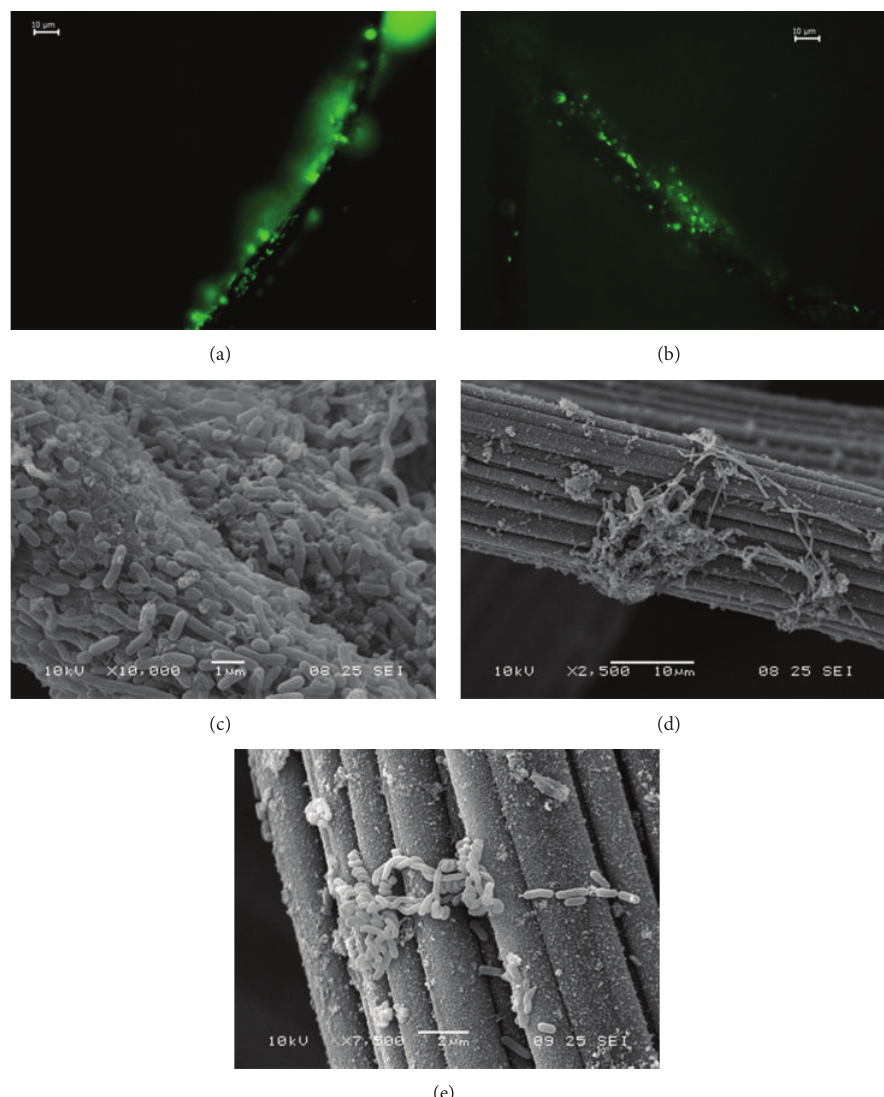
Figure 3: Fluorescence microscopy of the center of the biocathode revealed rod-shaped methanogens that were attached to the graphite felt fibers as single cells ((a) and (b)) or as microcolonies (a). Scanning electron microscopy (SEM) pictures of rod-shaped microorganisms at the center of the biocathode ((c), (d) and (e)). Part of the graphite felt was covered with a dense biofilm (c), while parts were only covered with clusters of microbial cells ((d) and